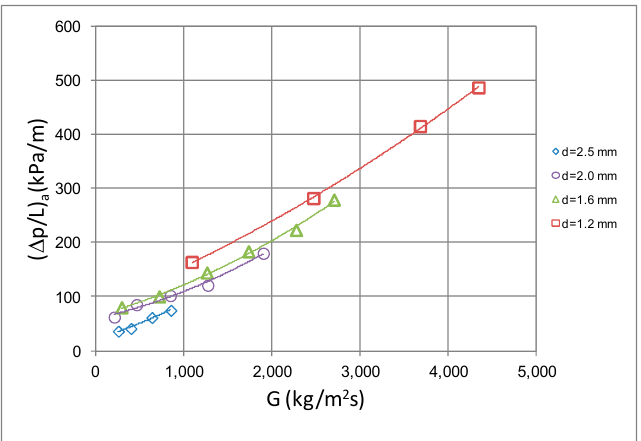
Figure 9. Dependence of pressure drops on internal diameter of minichannel ( Δ p/L) = f(d i ) for G ≈ 519 kg/m 2 s and inlet T s = 39 °C.